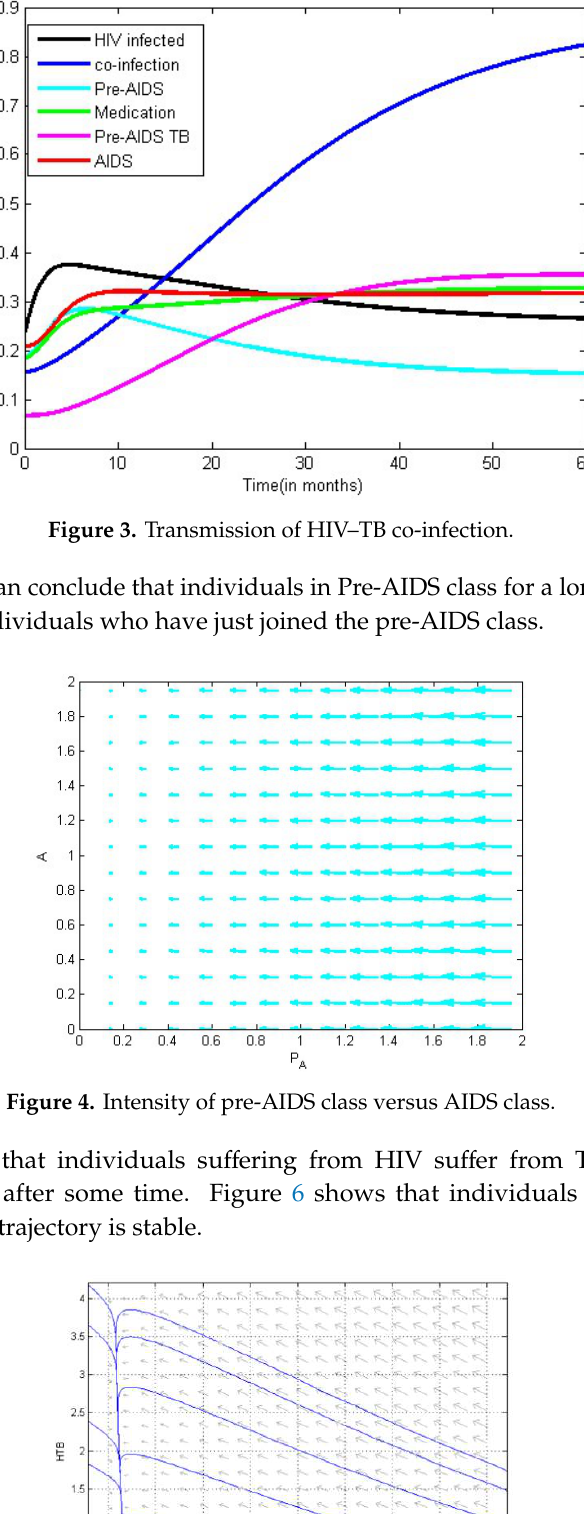
Figure 4. Intensity of pre-AIDS class versus AIDS class.